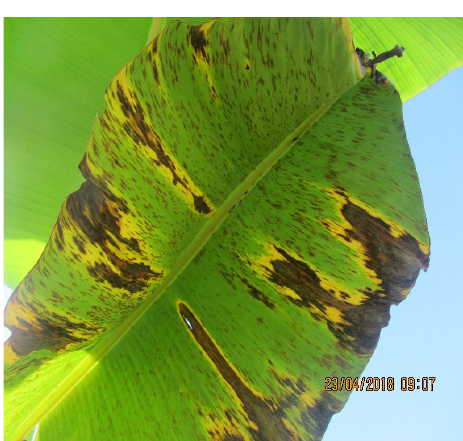
Figure 2. Leaf spots on palm heart. The small, blackish spots correspond to Colletotrichum siamense and the straw-colored spots to Neopestalotiopsis foedans .